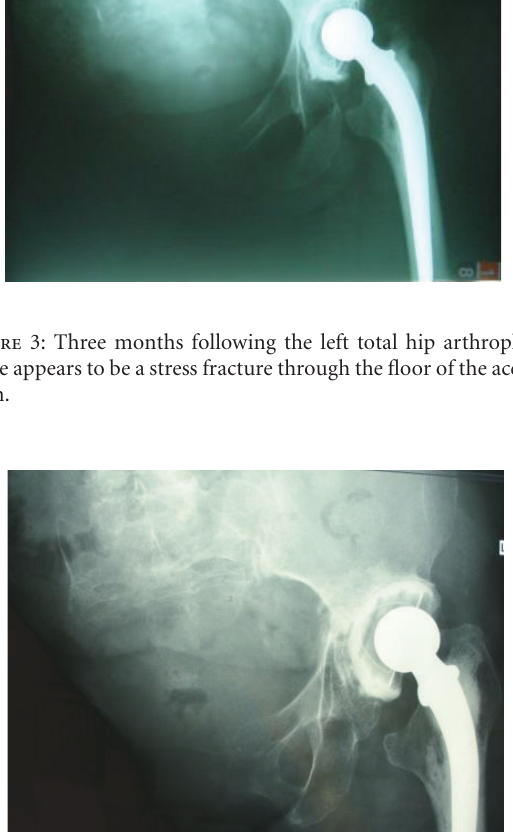
Figure 4: The radiological appearance of her pelvis 4 years after the total hip replacement. There has been some migration of the cemented cup but the hip causes her no